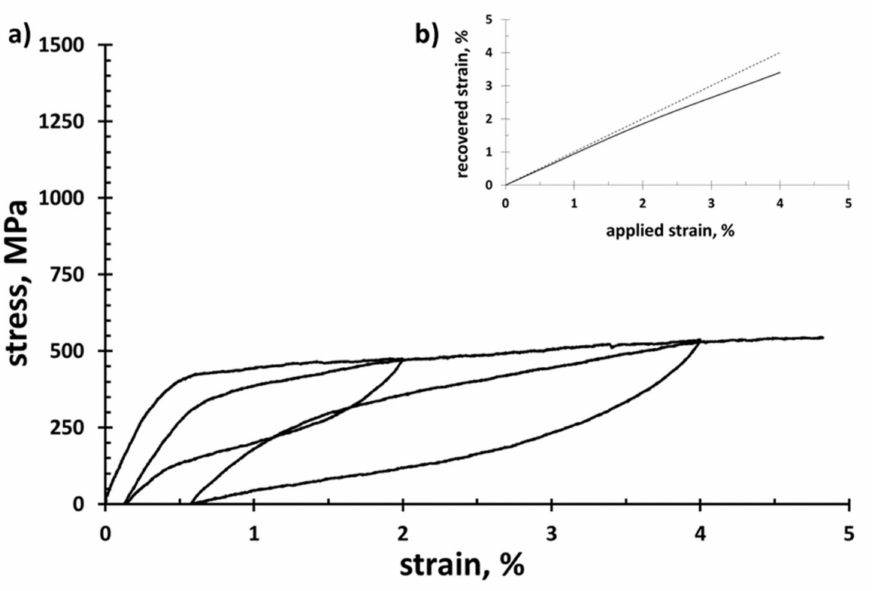
Figure 5. ( a ) Stress–strain response under tensile loading obtained from Fe-Mn-Al-Ni at RT after 5 HTC; ( b ) recovered strain plotted against the applied